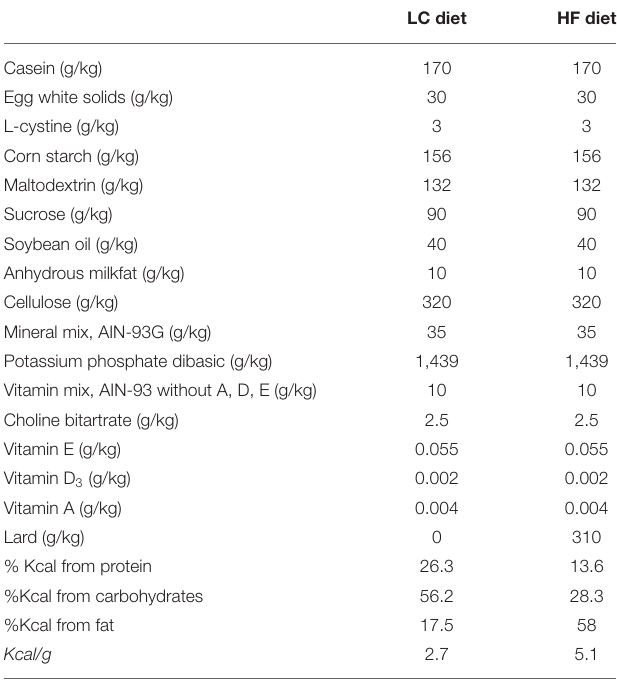
TABLE 1 | Macronutrient breakdown and energy densities for Low-calorie diet (LC) and high-fat diet